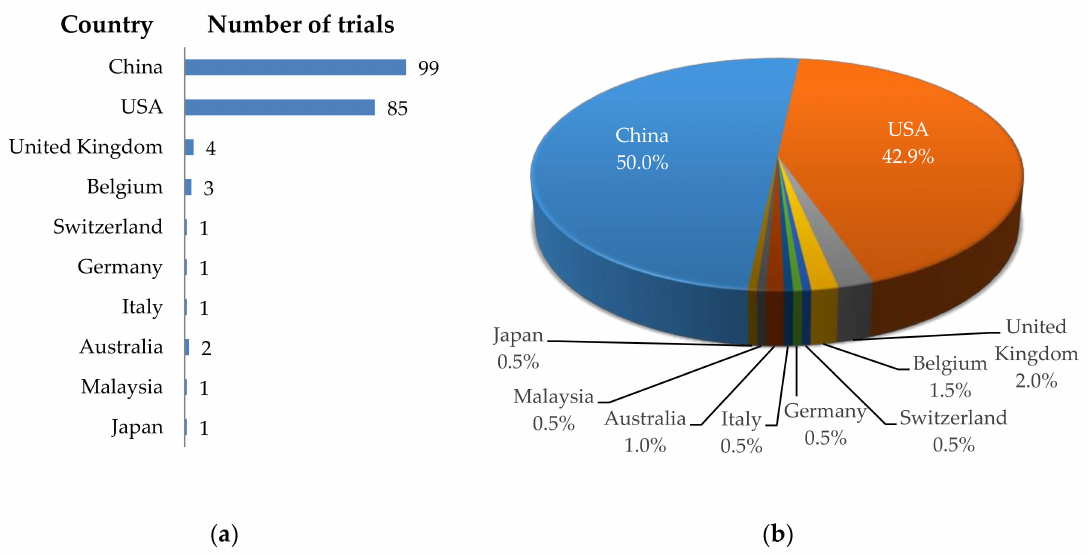
Figure 1. Schematic overview of the geographical distribution of clinical trials using CAR-T cells against solid tumors. ( a ) Number of clinical trials per country; ( b ) Proportional distribution of clinical trials per country. Data was extracted from